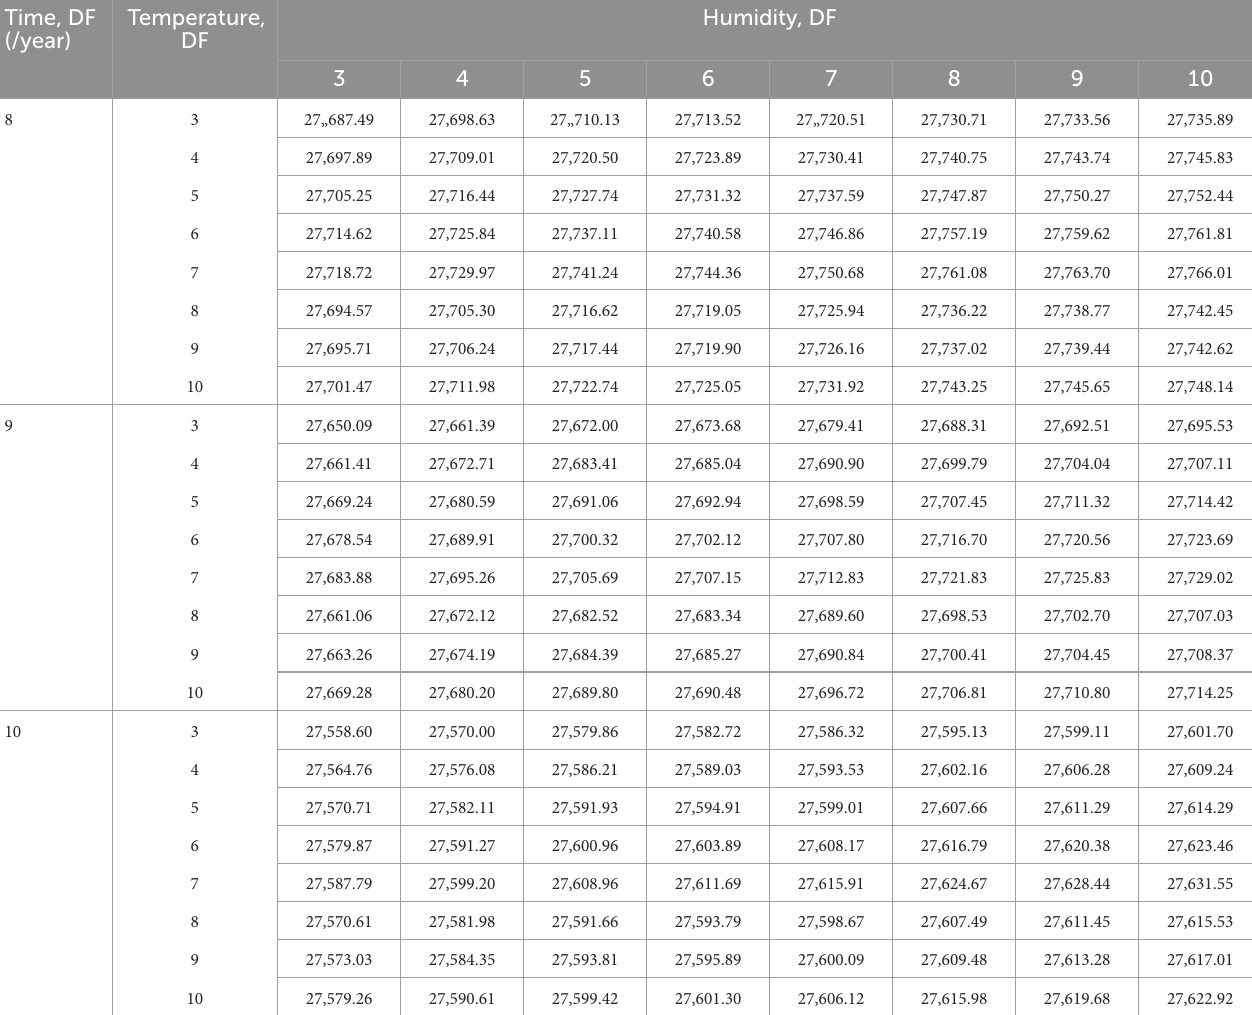
TABLE 3 Results of Akaike information criterion for quasi-Poisson (Q-AIC). Time, DF Temperature, (/year)